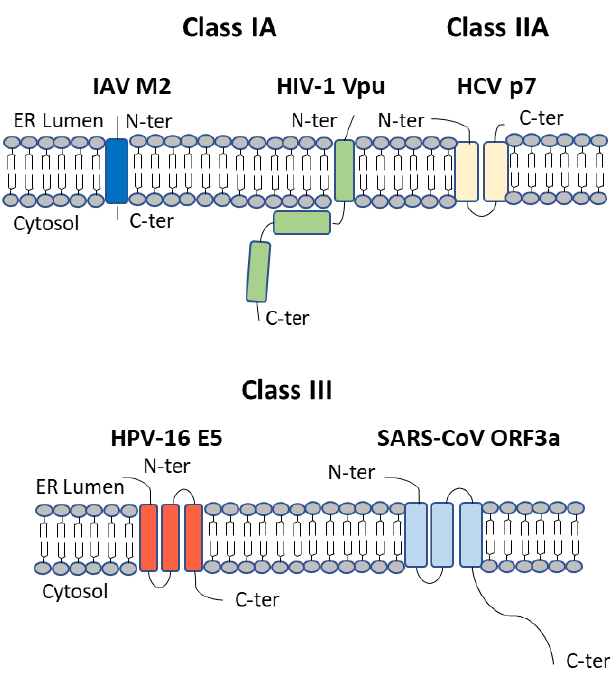
Figure 1. Viroporin Structure. Viroporins localise to intracellular membranes and possess at least one membrane spanning domain. They are divided into classes depending on the number of trans-membrane domains (TMDs). IAV M2 is a Class IA viroporin with a single TMD, a luminal N-terminus and C-terminal cytoplasmic tail. Vpu, also a class IA viroporin, is comprised of a short N-terminal domain, a hydrophobic TMD and a longer cytoplasmic domain, which includes the hinge region and two α -helical domains. HCV p7 is a class IIA viroporin with two transmembrane domains and luminal N and C termini. HPV-16 E5 and SARS-Co-V ORF3a are both class III viroporins with three membrane-spanning domains while SARS-CoV ORF3a has a long cytoplasmic